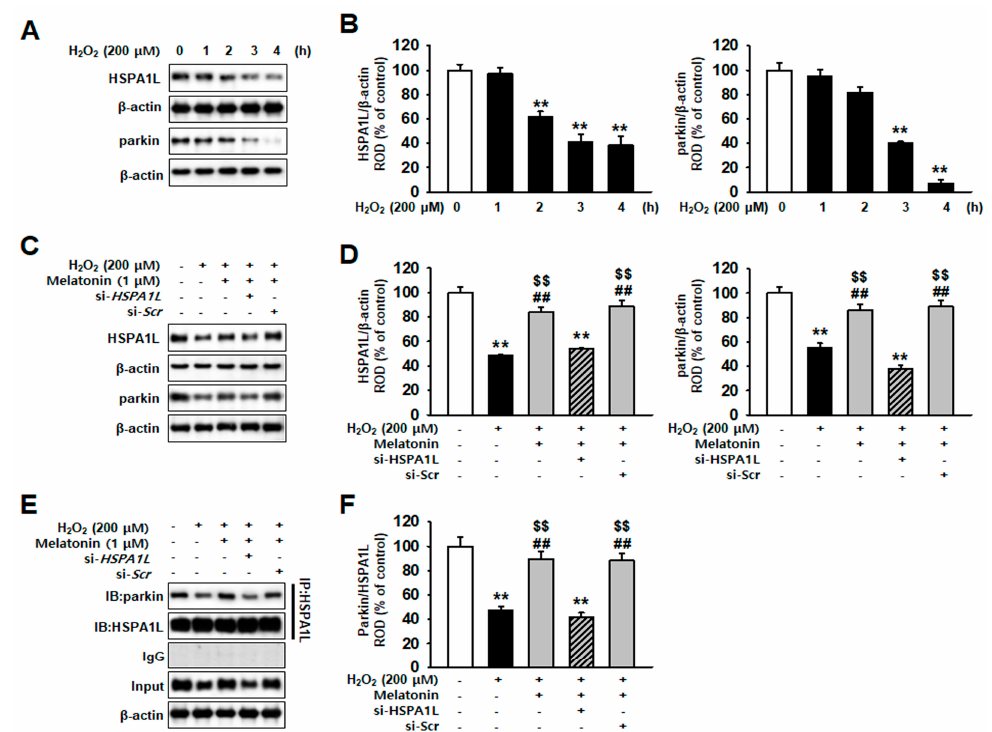
Figure 2. Melatonin enhances parkin stability by increasing HSPA1L expression in hMSCs subjected to oxidative stress. ( A ) Expression of HSPA1L and parkin in hMSCs treated with or without H 2 O 2 for various time periods (0, 1, 2, 3, and 4 h). ( B ) The expression levels of HSPA1L and parkin were normalized with respect to that of β -actin. Values represent the mean ± SEM. ** p < 0.01 vs. untreated hMSCs. ( C ) Expression of HSPA1L and parkin in hMSCs pretreated with HSPA1L siRNA (si- HSPA1L ) and 1 µ M melatonin for 24 h. ( D ) Expression levels of HSPA1L and parkin were normalized relative to those of β -actin. Values represent the mean ± SEM. ** p < 0.01 vs. untreated hMSCs; ## p < 0.01 vs. H 2 O 2 -treated hMSCs; $$ p < 0.01 vs. melatonin-treated hMSCs pretreated with si- HSPA1L . ( E ) Immunoprecipitates with anti-HSPA1L were analyzed after treatment of melatonin-pretreated hMSCs with si- HSPA1L by western blot using an antibody that recognized parkin. ( F ) The levels of parkin bound to HSPA1L were normalized with respect to that of β -actin. Values represent the mean ± SEM. ** p < 0.01 vs. untreated hMSCs; ## p < 0.01 vs. melatonin-treated hMSCs; $$ p < 0.01 vs. melatonin-treated hMSCs pretreated with si- HSPA1L .